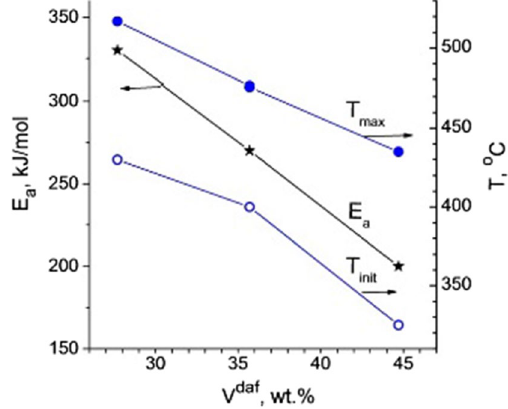
Fig. 9 The relations between the V T T E max , init and a for the second pyrolysis stage